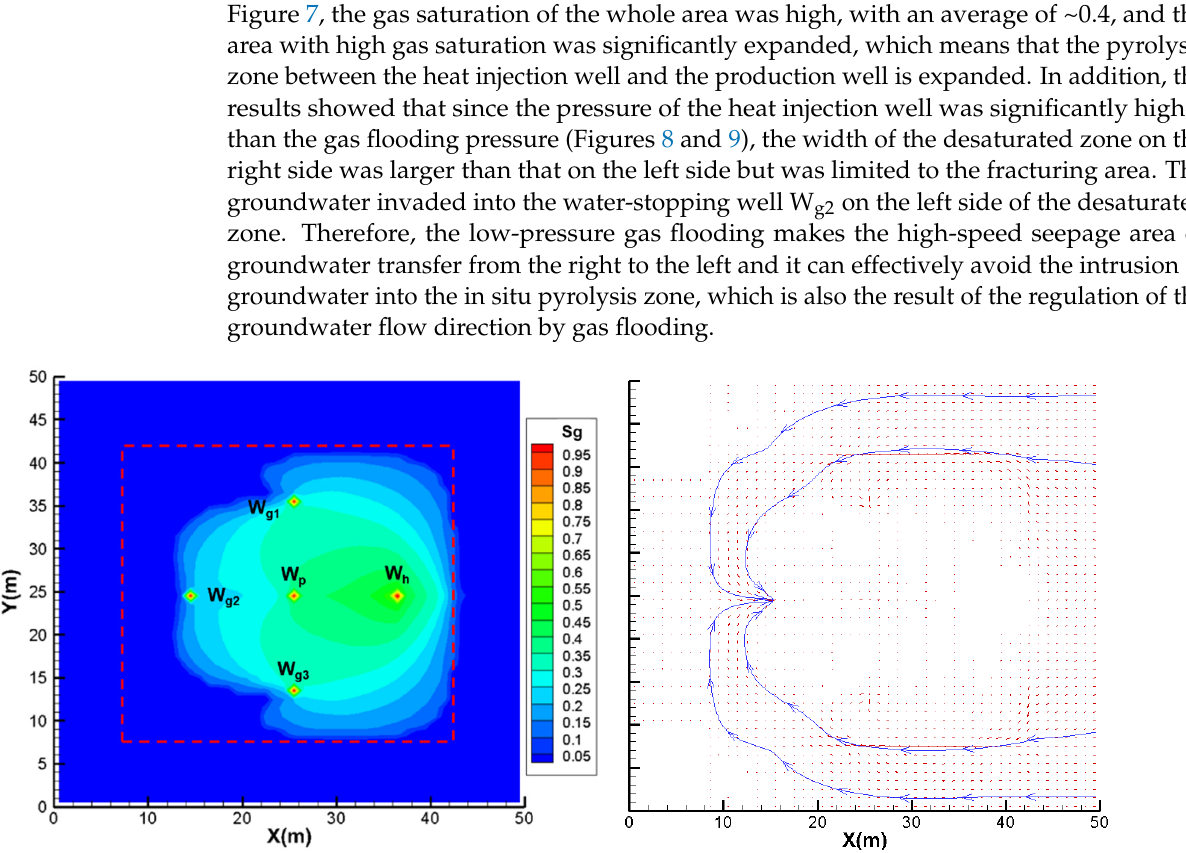
Figure 7. Gas saturation nephogram and groundwater flow traces in the gas flooding pressure of 5 MPa.